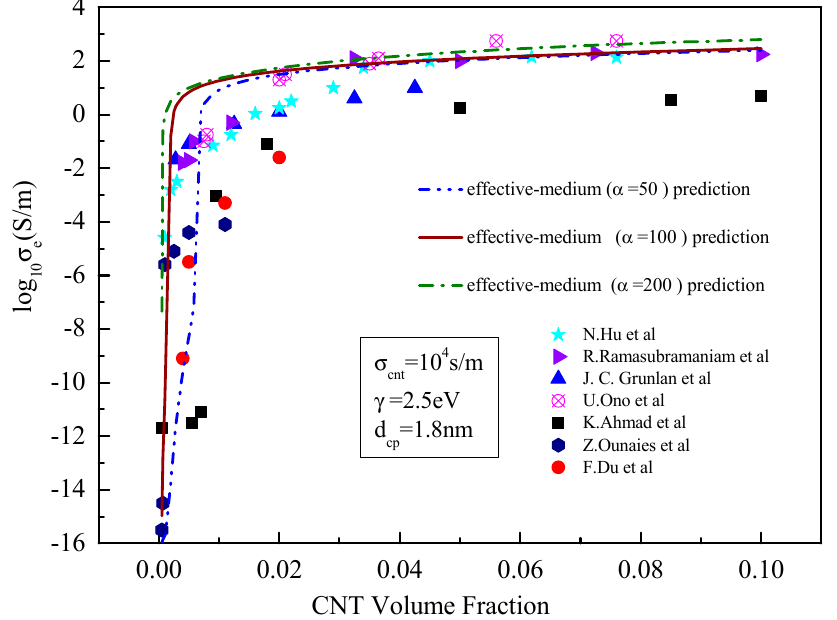
Figure 6. Comparison between the prediction results of the effective medium model and existing experimental data [21,23–28] with the variable CNT aspect ratio.